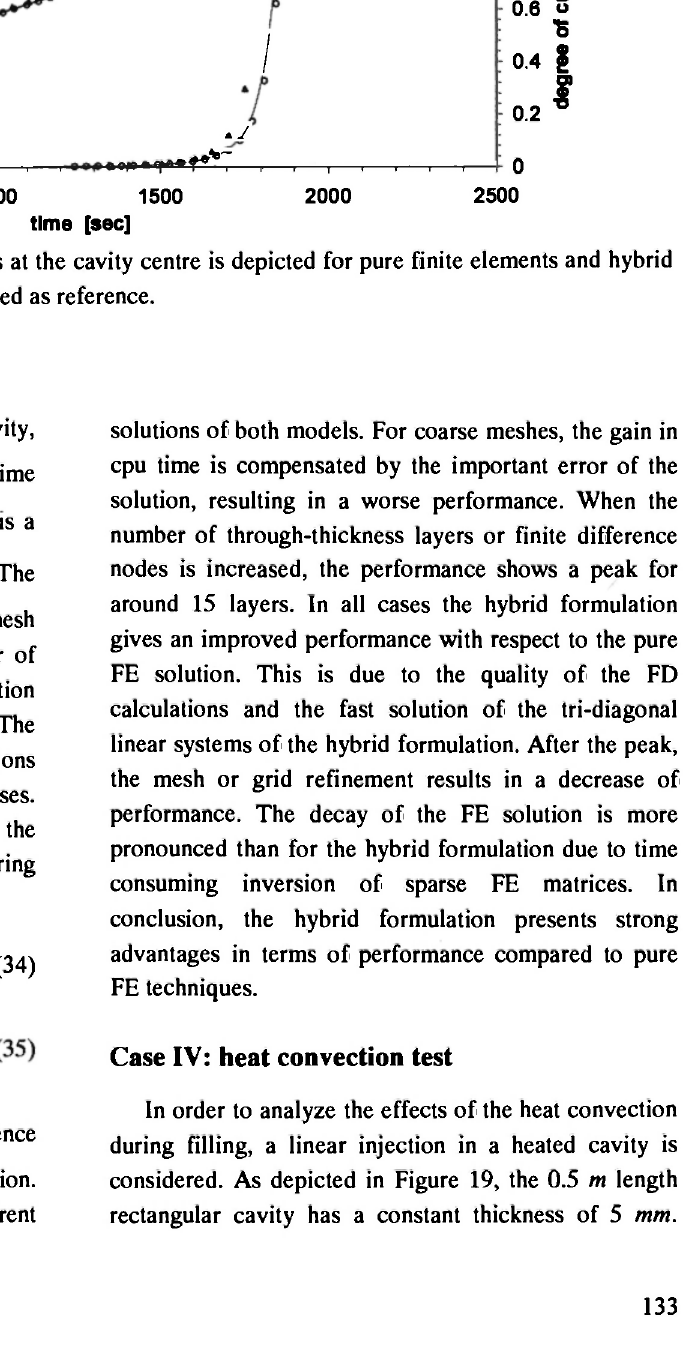
Evolution of temperature and cure profiles at the cavity centre is depicted for pure finite elements and hybrid FE/FD solutions. The 2D FE solution is used as reference.